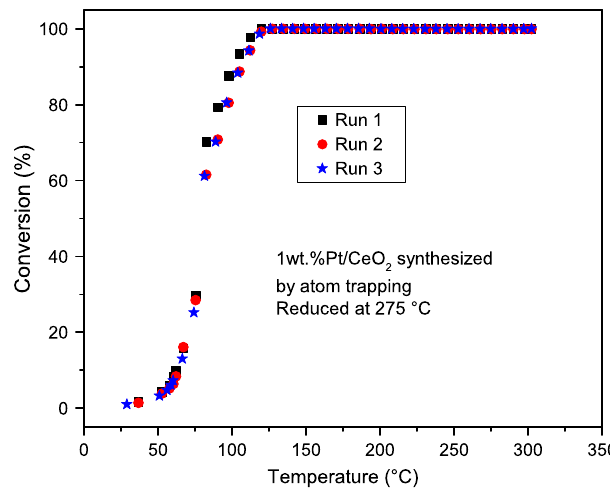
Fig. 1 Sequential CO oxidation. Sequential CO oxidation light-off curves up to 300 °C using a 1 wt%Pt/CeO 2 catalyst synthesized by atom trapping and further reduced at 275 °C with CO, as speci fi ed in Pereira-Hernández et al. 1